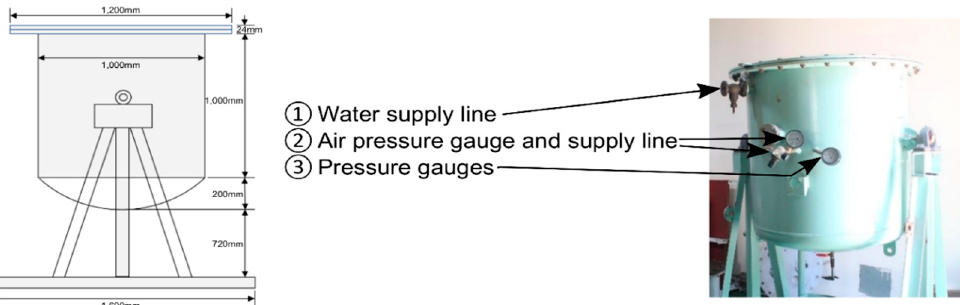
Figure 3. Water pressure test equipment [36].